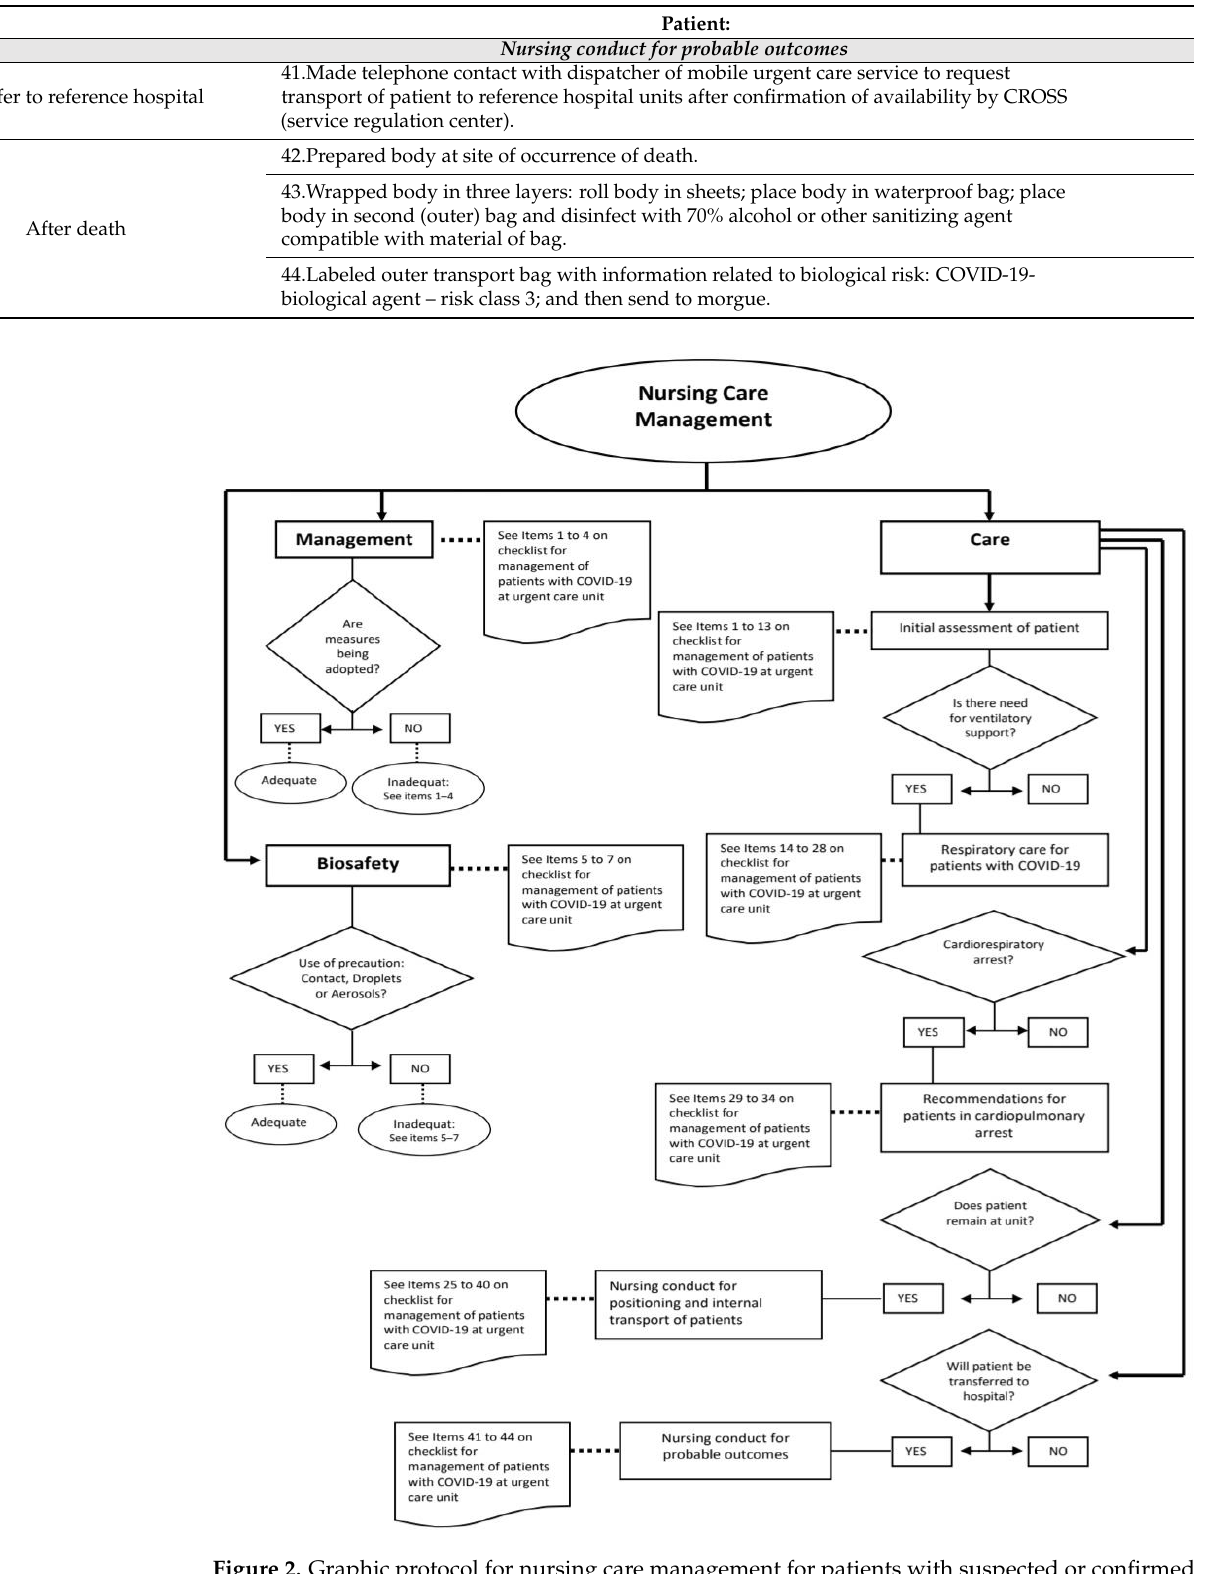
Figure 2. Graphic protocol for nursing care management for patients with suspected or confirmed infection by COVID-19 at a 24 h UCU.